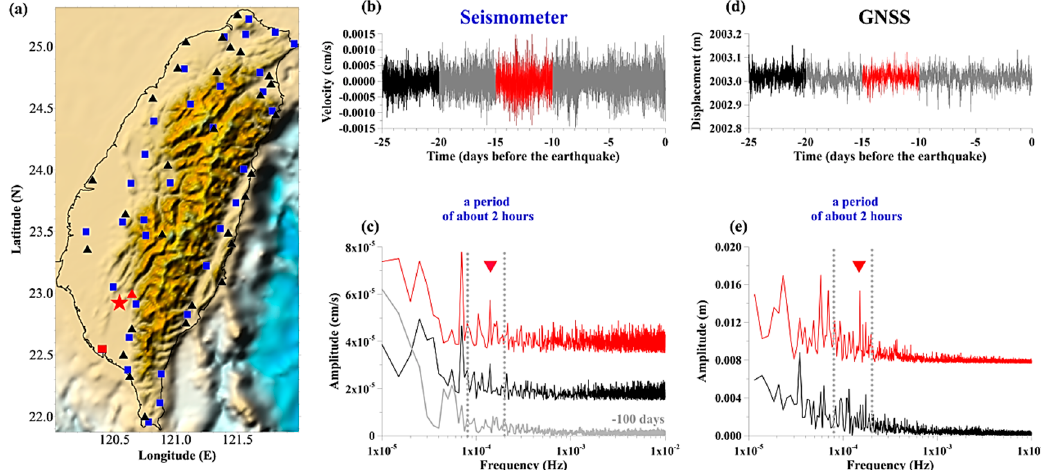
Figure 1. Locations of seismometers and ground-based Global Navigation Satellite Systems (GNSS) receivers on a topographic map and the variations of the vertical component data from two example stations for an interval of 0–25 days before the 2016 Meinong earthquake in Taiwan. Locations of seismometers and GNSS receivers are denoted by squares and triangles, respectively, in ( a ). The red star shows the epicenter. Seismic and GNSS data recorded by the B770 and LGUE stations are denoted by red symbols in ( a ) and are shown in ( b , c ) and ( d , e ), respectively. Note that the stations are selected based on the short epicentral distance and the continuity of the recorded data. ( b ) and ( d ) demonstrate changes in vertical velocity recorded by the seismic stations and vertical displacements recorded by the GNSS stations via the CSRS-PPP during an interval of 0–25 days before the earthquake, respectively. The amplitude varied with the frequency computed from the seismic and GNSS data in the interval of 20–25 days before the earthquake (black lines) and in the interval of 10–15 days (red lines) before the earthquake are shown in (c) and (e), respectively. Notably, the gray line shows the variations of amplitude retrieved from the seismic data 100 days in (c) for reference. Significant amplification of the amplitude can be found at frequencies of about 1.4 × 10 − 4 Hz (a period of